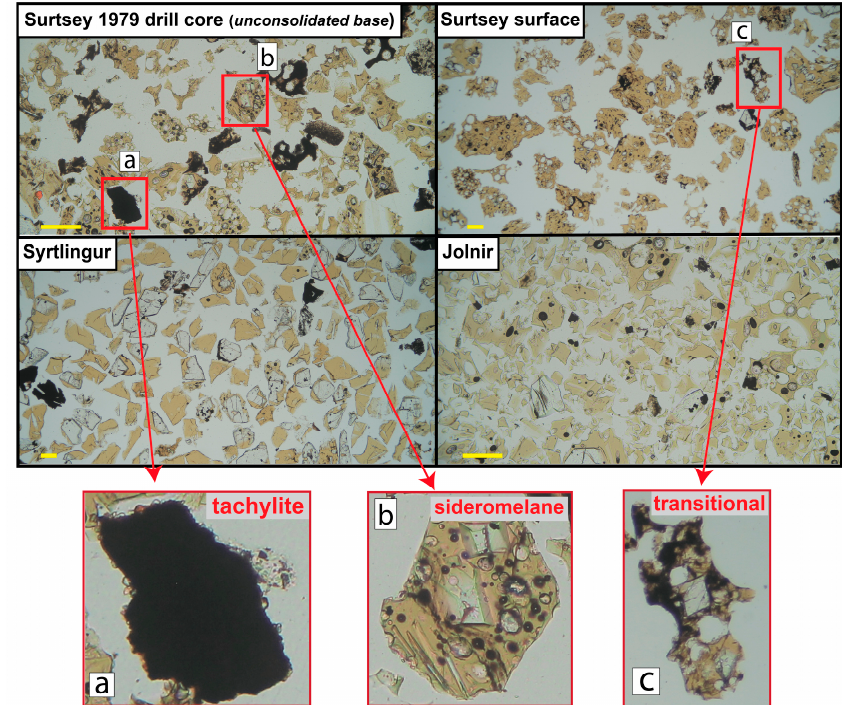
Figure 4. Photomicrographs (plane light) of ash grains from Surtsey and its satellite vents (from the Icelandic Natural History Museum samples collection, Table 1). Note the microtextural variability ( a - tachylite, b - sideromelane, c - transitional) across the grains from each location. The yellow bar length is 200 µm.